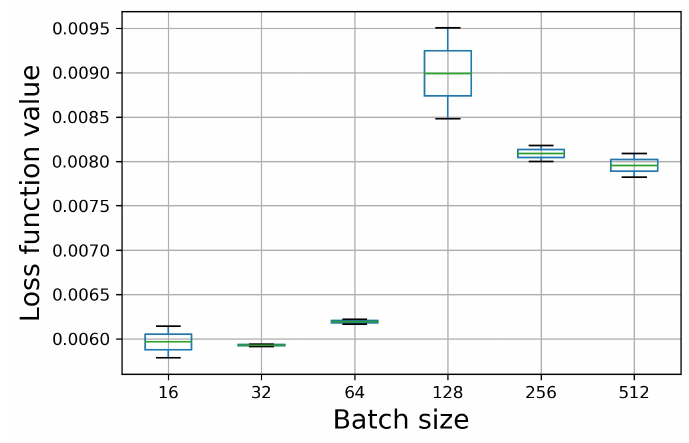
Figure 6. Bar error chart of model training loss under different batch sizes.